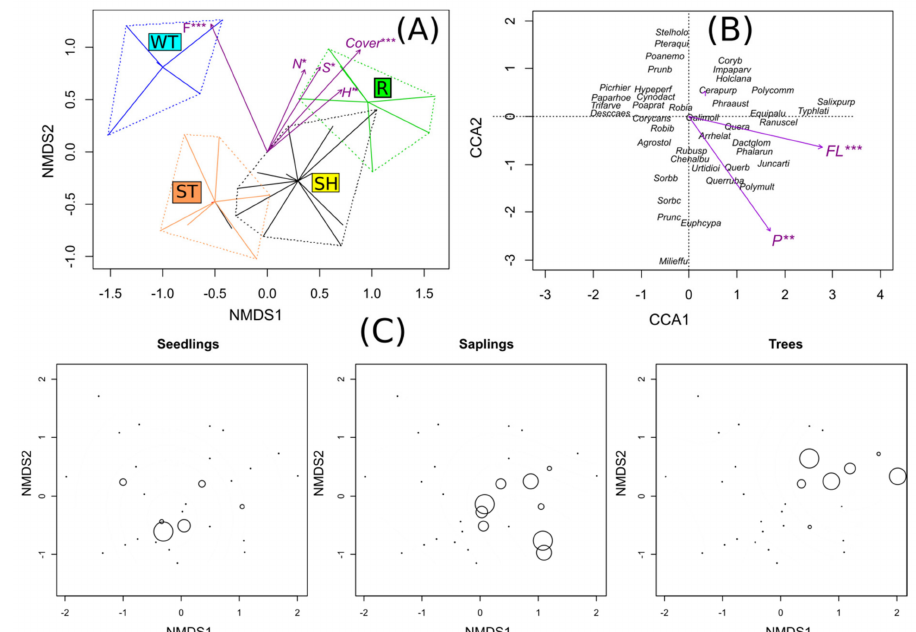
Figure 2. Nonmetrical Multidimensional Scaling (NMDS) and Canonical Correspondence Analysis (CCA). NMDS centroids ( A ), biplot of the study plots and environmental factors according to the CCA ( γ 1 = 0.5954 γ 2 = 0.5443 and for which the cumulative explained proportion was 0.3350 and 0.6413 for the two axes, respectively) ( B ) and ordination of the Robinia pseudoacacia in relation to the layer and cover ( C ). Explanations: Cover—total cover of plants, S—species richness, H’—Shannon-Wiener index, N—nitrogen, FL—floatable parts fraction, *— p < 0.05; **— p < 0.01, ***— p < 0.001. 1 R—reference site, adjacent forest, SH—sand heaps, ST—sandy bottom of the sedimentation tank,